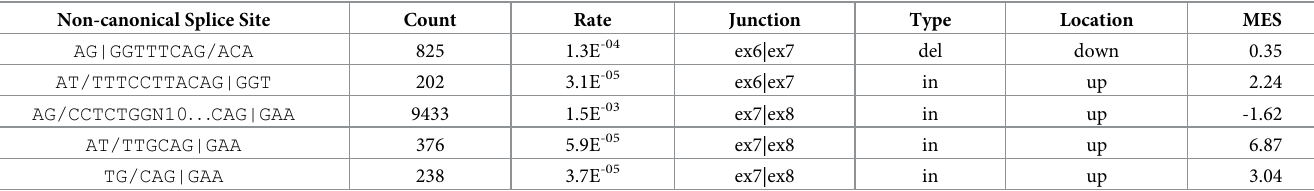
Table 2. Non-canonical 3’ splice site usage.